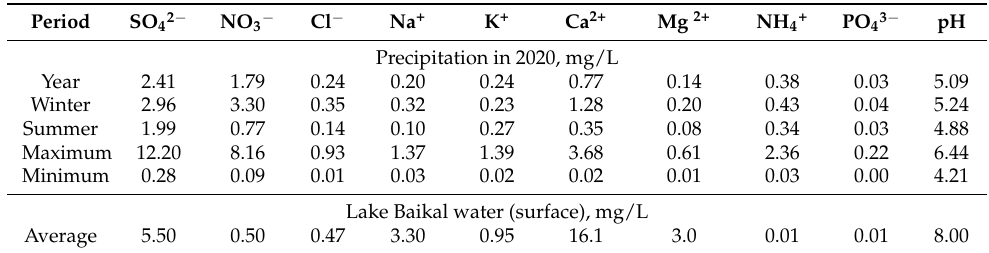
Table 3. Ionic concentrations in precipitation (2020) at the Listvyanka station and in Lake Baikal water.